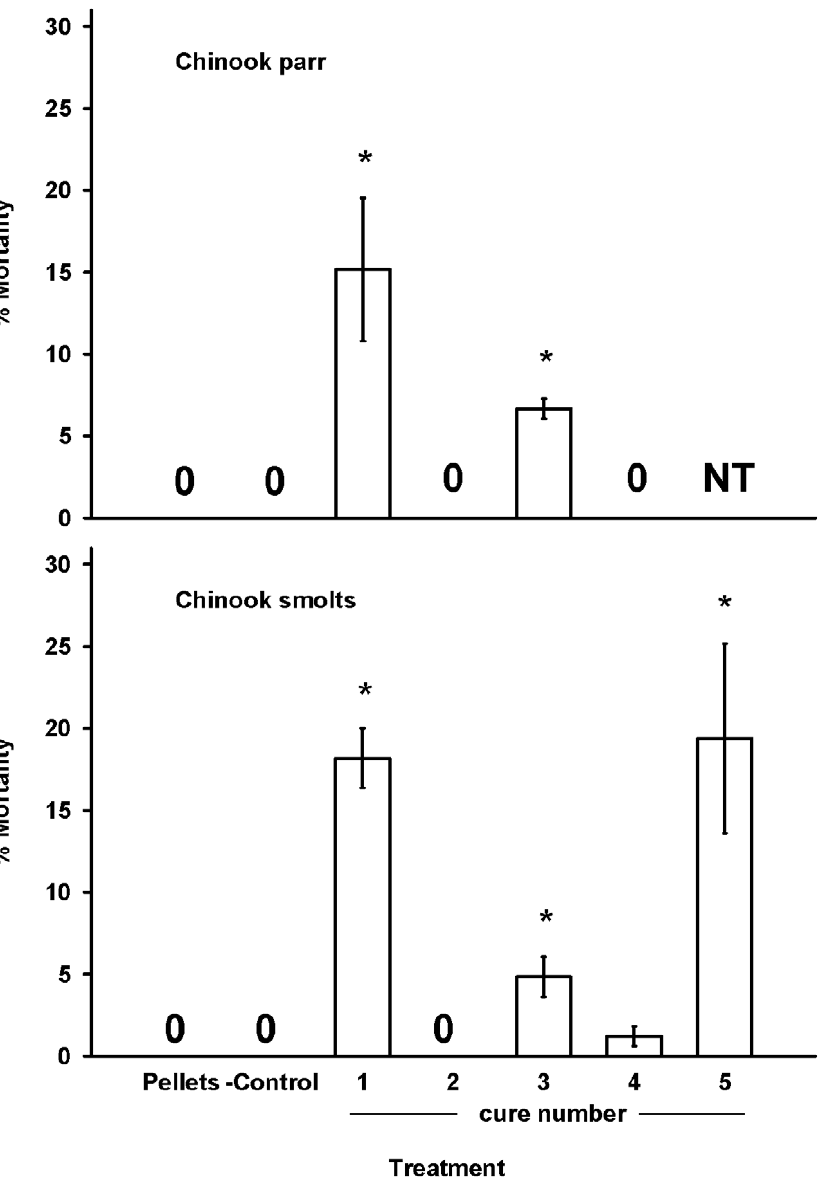
Figure 2. Juvenile spring Chinook parr and smolt mortality. Juvenile juvenile spring Chinook parr or smolts were fed for 23 d with pellets, salmon eggs (- control), or salmon eggs cured with 1 of 4 or 5 commercially available cures. Bars represent the mean % mortality for three replicate tanks (N=55 fish per tank). A value of 0 represents treatments that had no mortality in all three tanks. NT=Not Tested. *Significantly different from the group fed pellets ( P , 0.05).